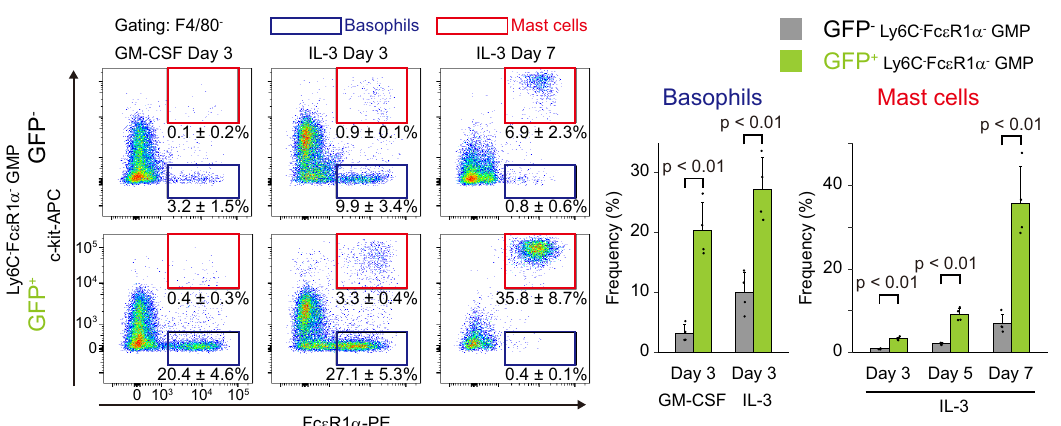
Fig. 4 | The Myb -68 enhancer enriches basophil/mast cell-biased GMPs before Fc ε R1 α surface expression. Representative FACS plots of GFP - (upper) and GFP + (lower) Ly6C - Fc ε R1 α - GMPs cultured in vitro in the presence of GM-CSF or IL-3 for indicated periods of time. FACS gating strategies are shown in Supplementary Figure 14a. Numbers shown are mean percentages±SD of basophils, de fi ned as Fc ε R1 α + c-kit - (blue), and mast cells, de fi nedasFc ε R1 α + c-kit + (red). The percentages